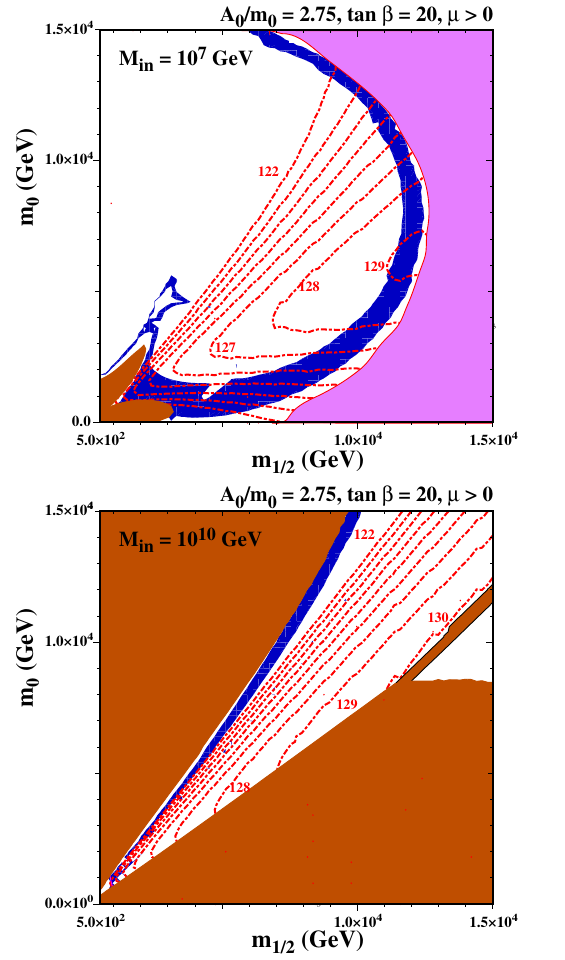
(lower right). The pink region is where μ 2 < 0 and radiative EWSB is not possible. Other shadings used here are the same as Fig. 6. The shading for the relic density is enhanced so that 0 . 06 < (cid:12) h 2 < 0 .